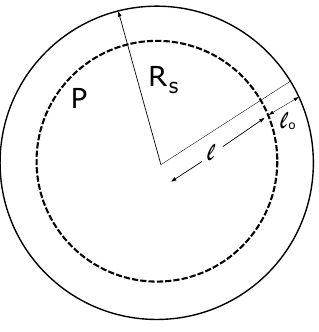
Figure 3: Schematic representation of a Schwarzschild black hole and the parameters in scenario 2. The dashed circle is constant r and t hypersurface P . Distance (cid:96) from the point where the NEC starts being violated, and distance (cid:96) is from P to the singularity (pictured here at r =